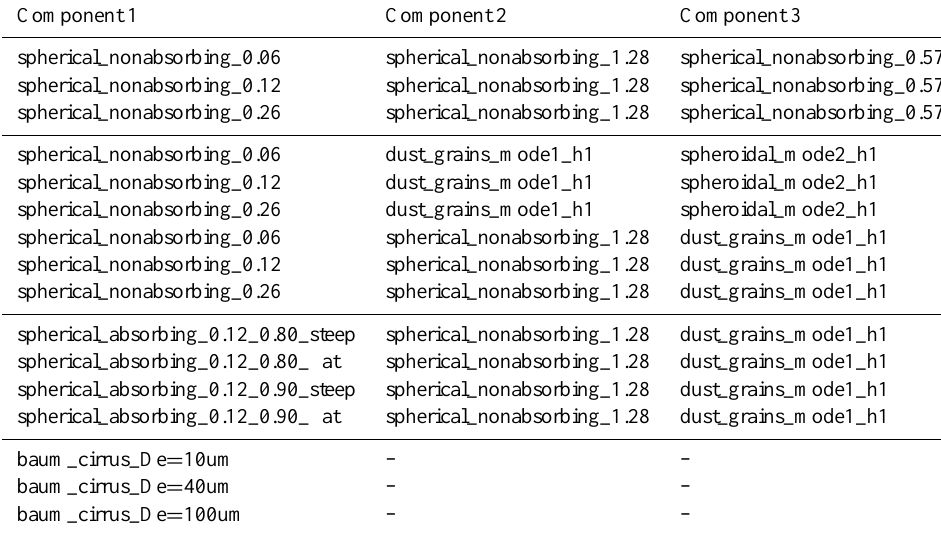
Table 5. Mixing groups comprising the 774-mixture